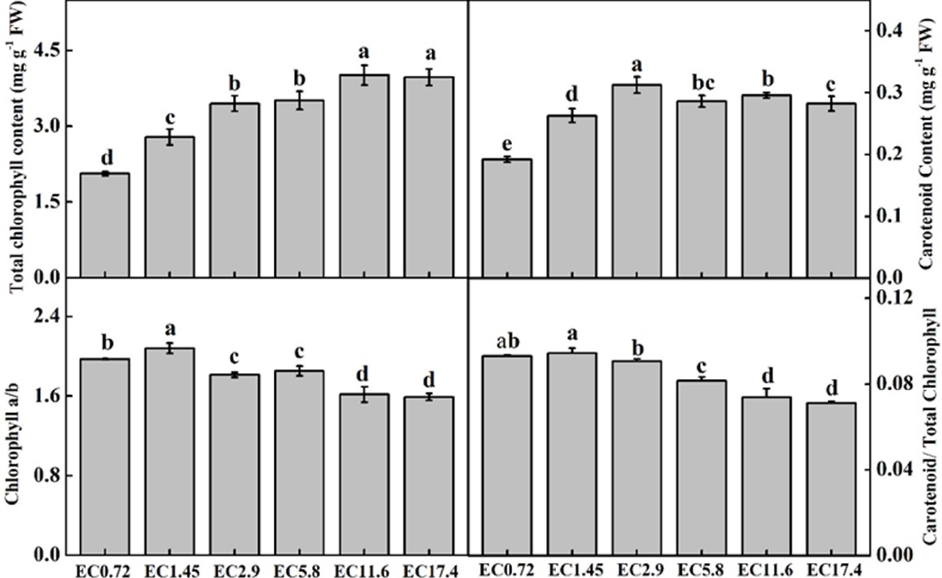
Figure 3. Effects of different EC treatments on the total chlorophyll content, carotenoid content, chlorophyll a/b, and carotenoid/total chlorophyll of different treatments after 25 days. EC0.72, EC1.45, EC2.9, EC5.8, EC11.6, and EC17.4 represent the different nutrient solution electrical conduc- tivities of 0.72 dS m −1 , 1.45 dS m −1 , 2.9 dS m −1 , 5.8 dS m −1 , 11.6 dS m −1 , and 17.4 dS m −1 . Data represent the mean ± SD ( n = 3). Different letters indicate significant differences at a = 0.05 based on the Least Significant Difference